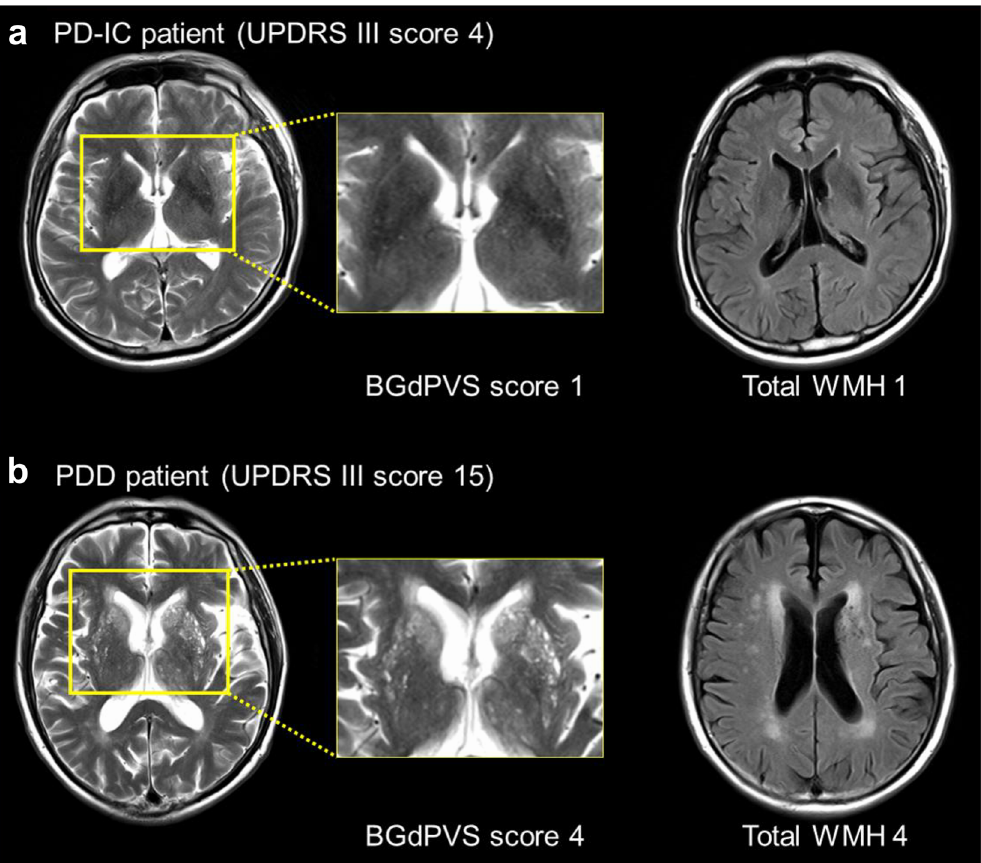
Fig. 2 Representative cases showing the associations of BGdPVS and WMH with cognitive status and motor symptoms. a A 72-year-old male diagnosed as PD-IC, with a UPDRS III score of 4. The patient did not have a history of hypertension or SH. The axial T2-weighted images show a BGdPVS score of 1. On FLAIR images, the total Fazekas score of WMH was 1. b A 79-year-old male diagnosed with PDD, with a UPDRS III score of 15. The patient had hypertension and SH. The axial T2-weighted images show BGdPVS score of 4. On FLAIR images, the total Fazekas score of WMH was 4. Abbreviations: BG basal ganglia, dPVS dilated perivascular spaces, FLAIR fl uid-attenuated inversion recovery, PD-IC PD with intact cognition, PDD PD with dementia, SH supine hypertension, UPDRS III Uni fi ed Parkinson ’ s Disease Rating Scale Part III, WMH white- matter